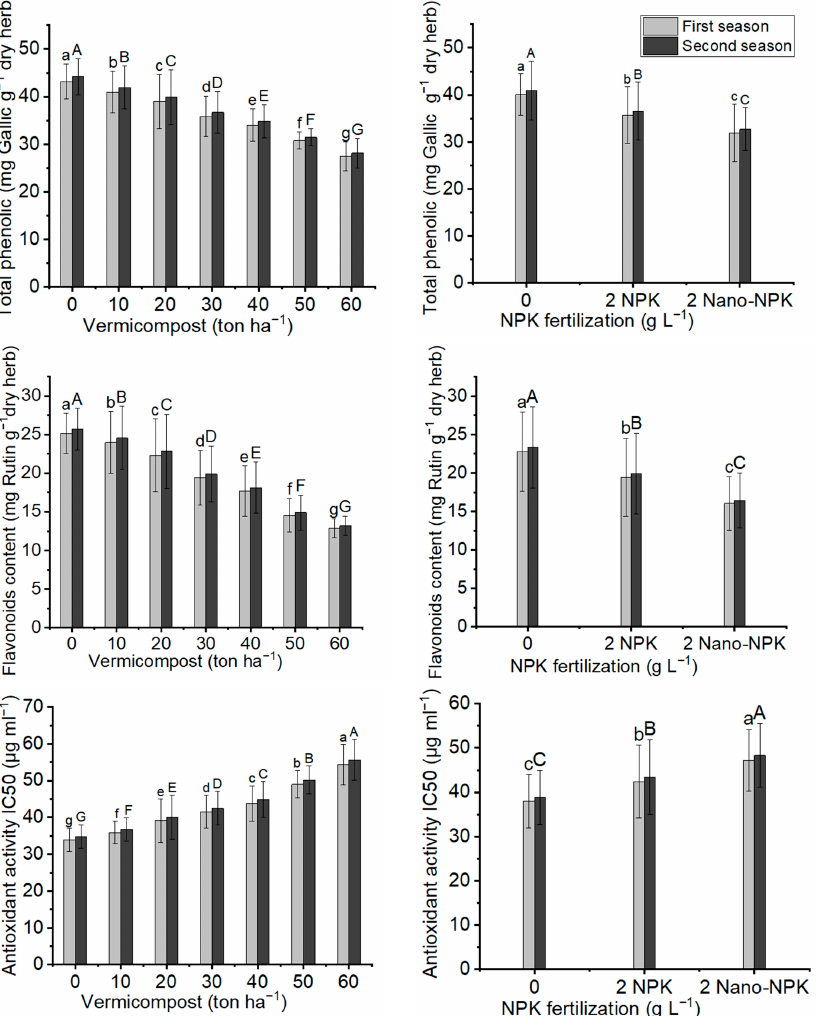
Figure 6. In both seasons of the study, the mean values of total phenolic (mg Gallic g − 1 dry herb), flavonoids content (mg Rutin g − 1 dry herb), and antioxidant activity IC 50 (µg mL − 1 ) of Moringa oleifera trees as influenced by vermicompost and NPK fertilization are provided below. The data are presented as a mean with standard error ( n = 3). Bars with identical lowercase letters are not significant at the 0.05 level of probability.